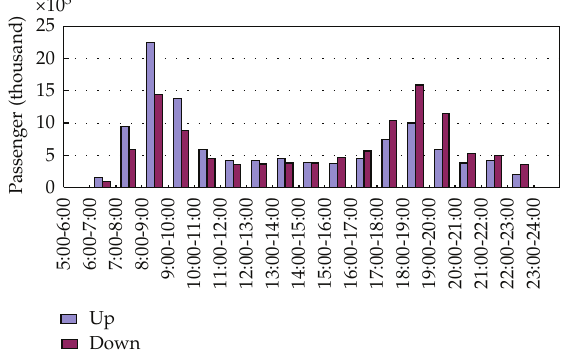
Figure 4: Daily Passenger flow in two ride directions of line 8 in